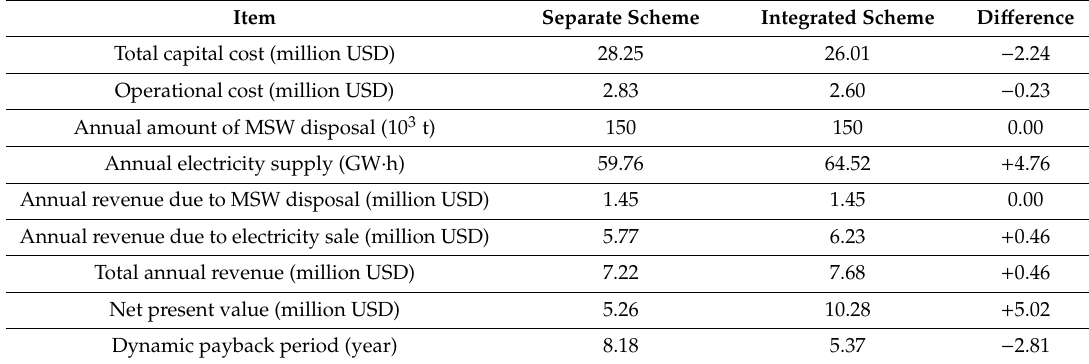
Table 14. Economic analysis results of the WtE section in the two